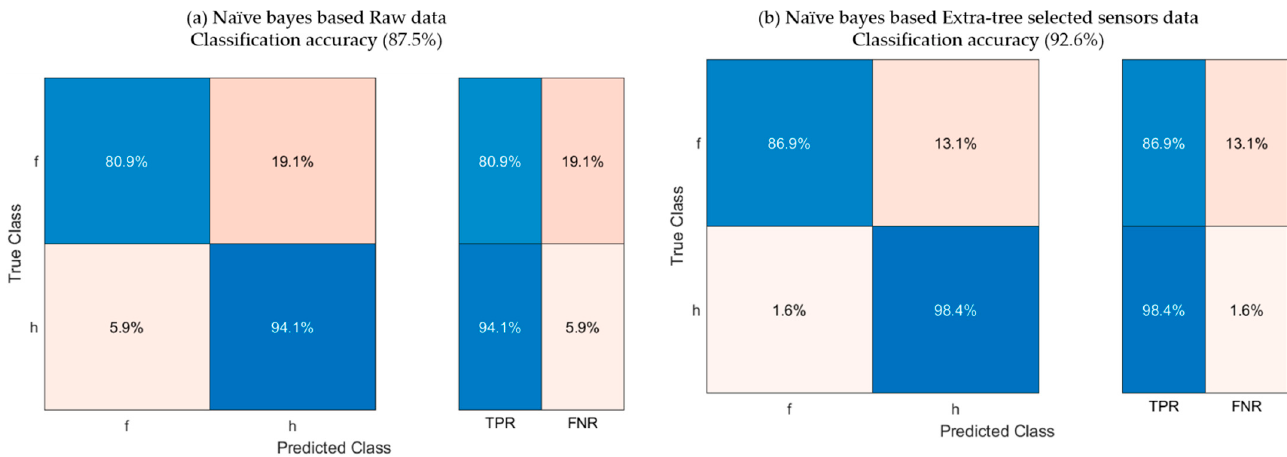
Figure 22. ( a ) Confusion matrix for the naïve-Bayes-based raw data case scenario; ( b ) confusion matrix for the naïve-Bayes- based extra-tree classifier case scenario.